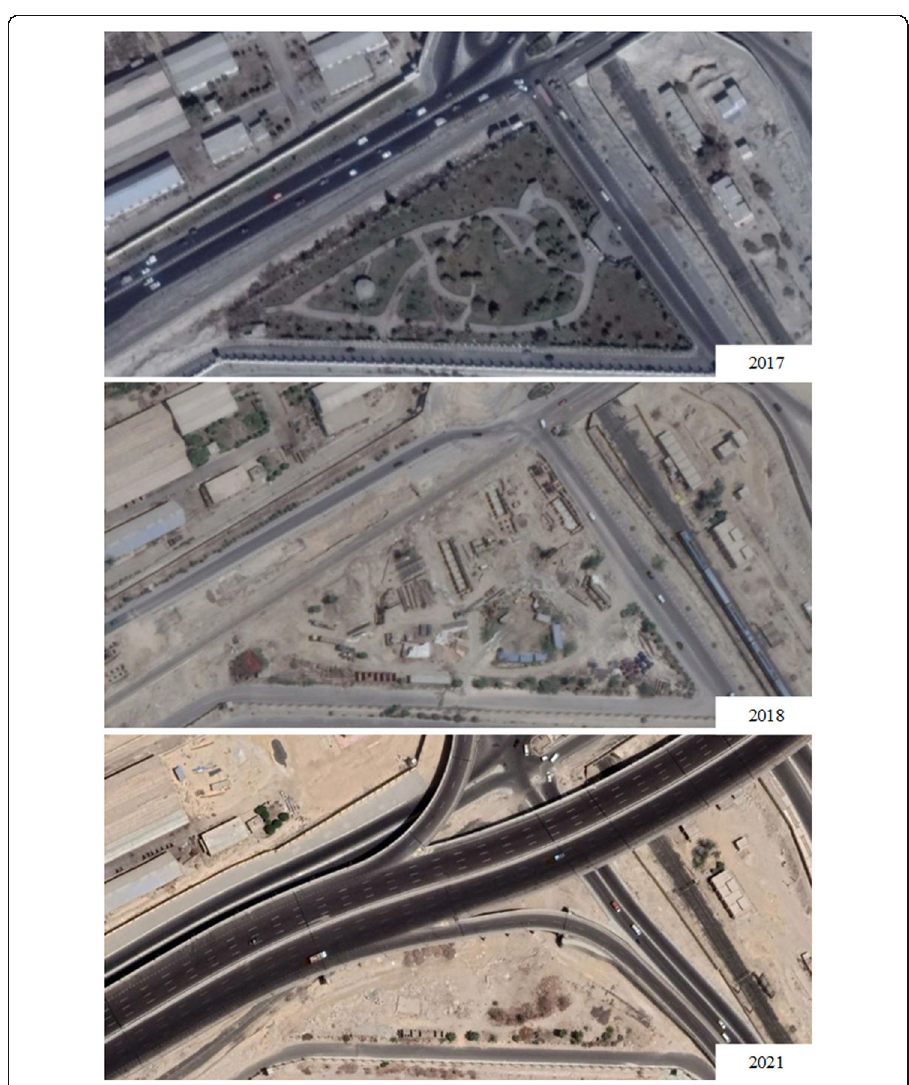
Fig. 9 al-Mostaqbl Park, Helwan District, Map data © 2021